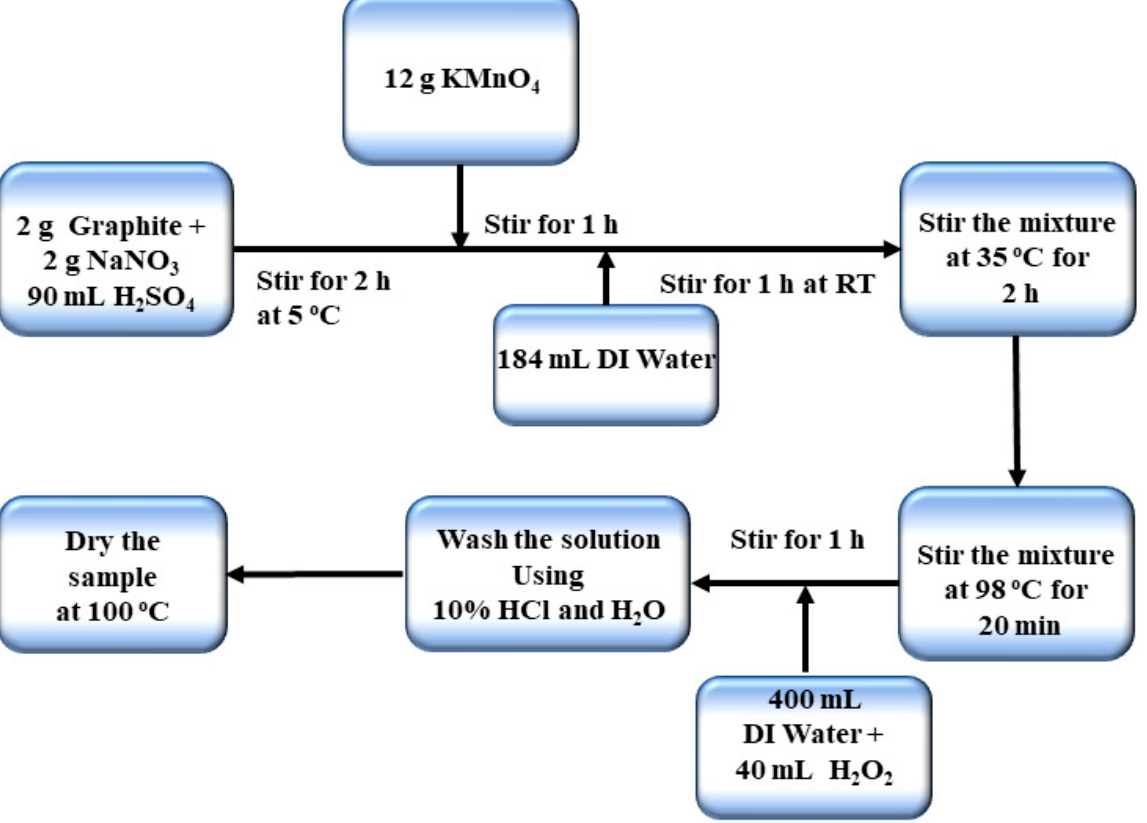
Figure 1. Schematic representation of graphene oxide synthesis .